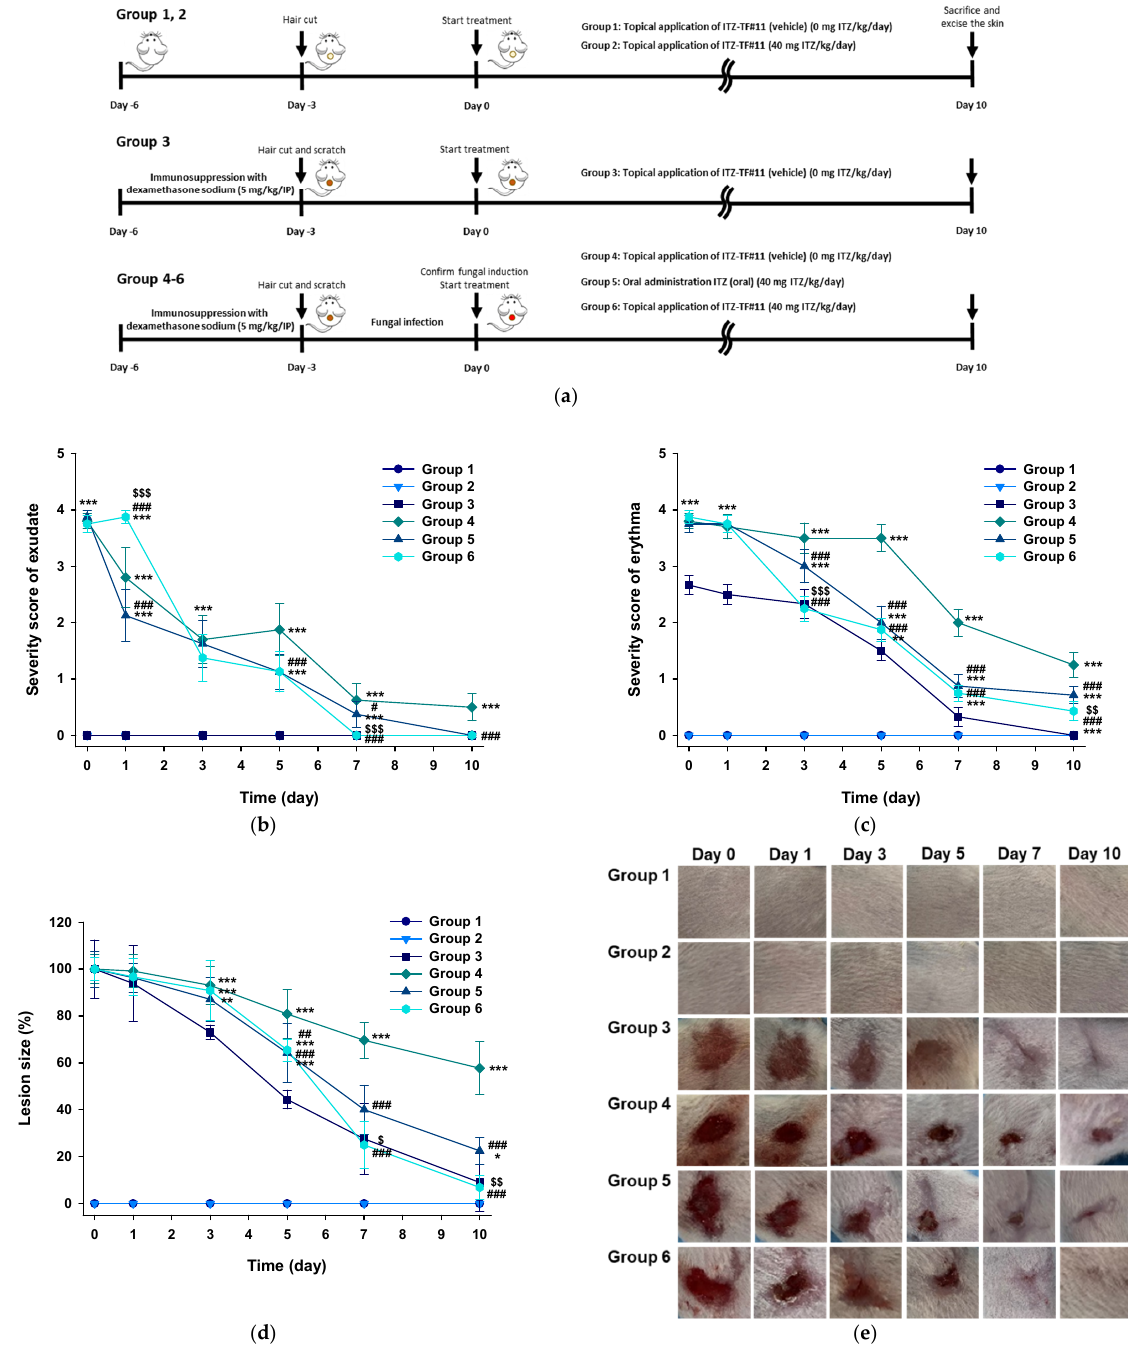
Figure 3. In vivo antifungal efficacies of once-daily oral or topical ITZ treatments in a mouse model of dermal Candida albicans infection. ( a ) Fungal infections and treatment schedules for once-daily oral and topical administrations of 40 mg/kg ITZ and ITZ–TF#11 (vehicle) or ITZ–TF#11 (equivalent to 40 mg/kg ITZ), respectively. ( b ) Exudates and ( c ) erythema from/on mouse skin lesions infected or not with C. albicans and treated with topical ITZ–TF#11 (vehicle) or ITZ–TF#11 or oral ITZ for 10 days. ( d ) Lesion sizes and ( e ) representative photographs of normal skin treated with ITZ–TF#11 (vehicle) (group 1) or ITZ–TF#11 (group 2); scratched skin treated with ITZ–TF#11 (group 3); and scratched and fungus-infected skin treated with ITZ–TF#11 (vehicle) (group 4), oral ITZ (group 5), and ITZ–TF#11 (group 6) for 10 days. Each value represents a mean ± standard deviation ( n = 10 for each group). * p < 0.05, ** p < 0.01, *** p < 0.001 compared to scratched skin treated with ITZ–TF#11 (group 3). ## p < 0.01, ### p < 0.001 compared to scratched and fungus-infected skin treated with ITZ–TF#11 (vehicle) (group 4). $ p < 0.05, $$ p < 0.01, $$$ p < 0.001 compared to scratched and fungus-infected skin treated with oral ITZ (group